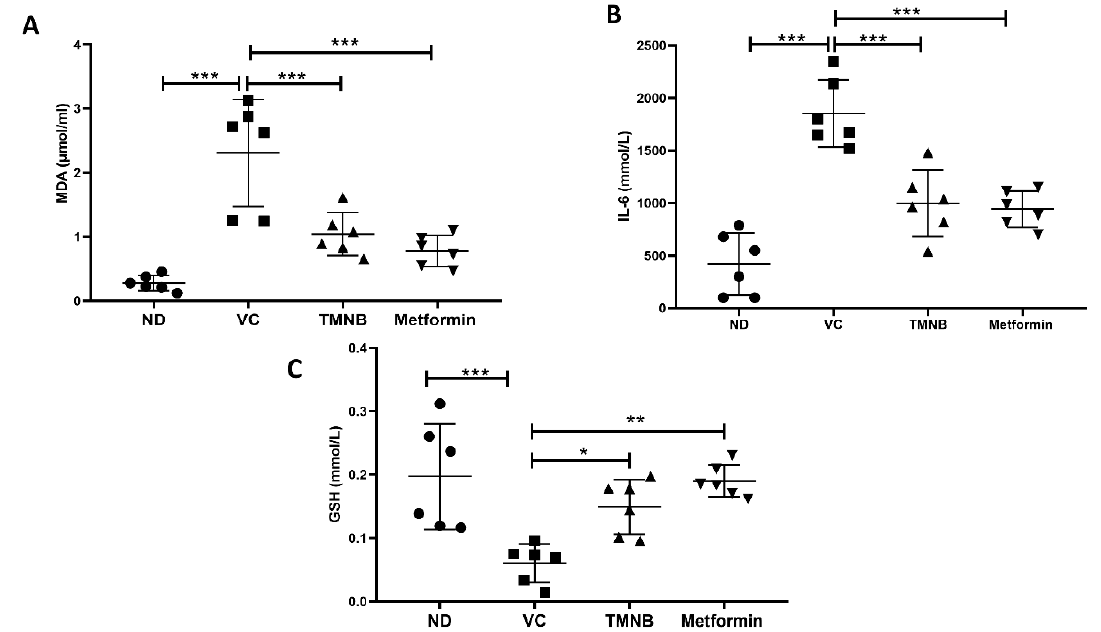
Figure 7. The anti-inflammatory effect of 2 ′ ,3,3,5 ′ -Tetramethyl-4 ′ -nitro-2 ′ H-1,3 ′ -bipyrazole. TMNB significantly reduced MDA ( A ) and IL-6 ( B ) levels and increased GSH ( C ) systemic concentration in diabetic rats. Rats were fed HFD for 3 weeks, followed by a single dose of STZ injection (40 mg/kg); and once diabetes was confirmed, rats were treated with 10 mg/kg TMNB or 200 mg/kg metformin for 10 days. After the end of the experiment following euthanasia, serum was collected for ELISA analysis. One-way ANOVA was followed by Tukey post-hoc multiple comparison test, * < 0.05, ** < 0.01, *** < 0.001. ND; non-diabetic, VC; vehicle control, TMNB; 2 ′ ,3,3,5 ′ -Tetramethyl-4 ′ -nitro-2 ′ H-1,3 ′ -bipyrazole.